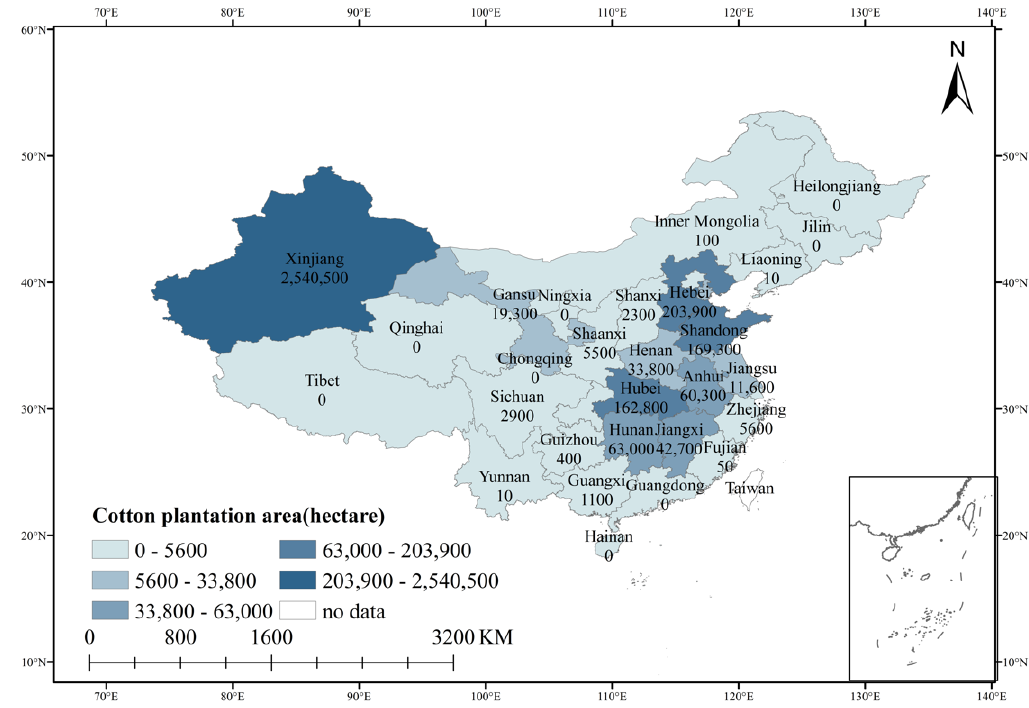
Figure 1. Cotton planting area in each province in China (The source of the data for making the map is “China Rural Statistical Yearbook”).